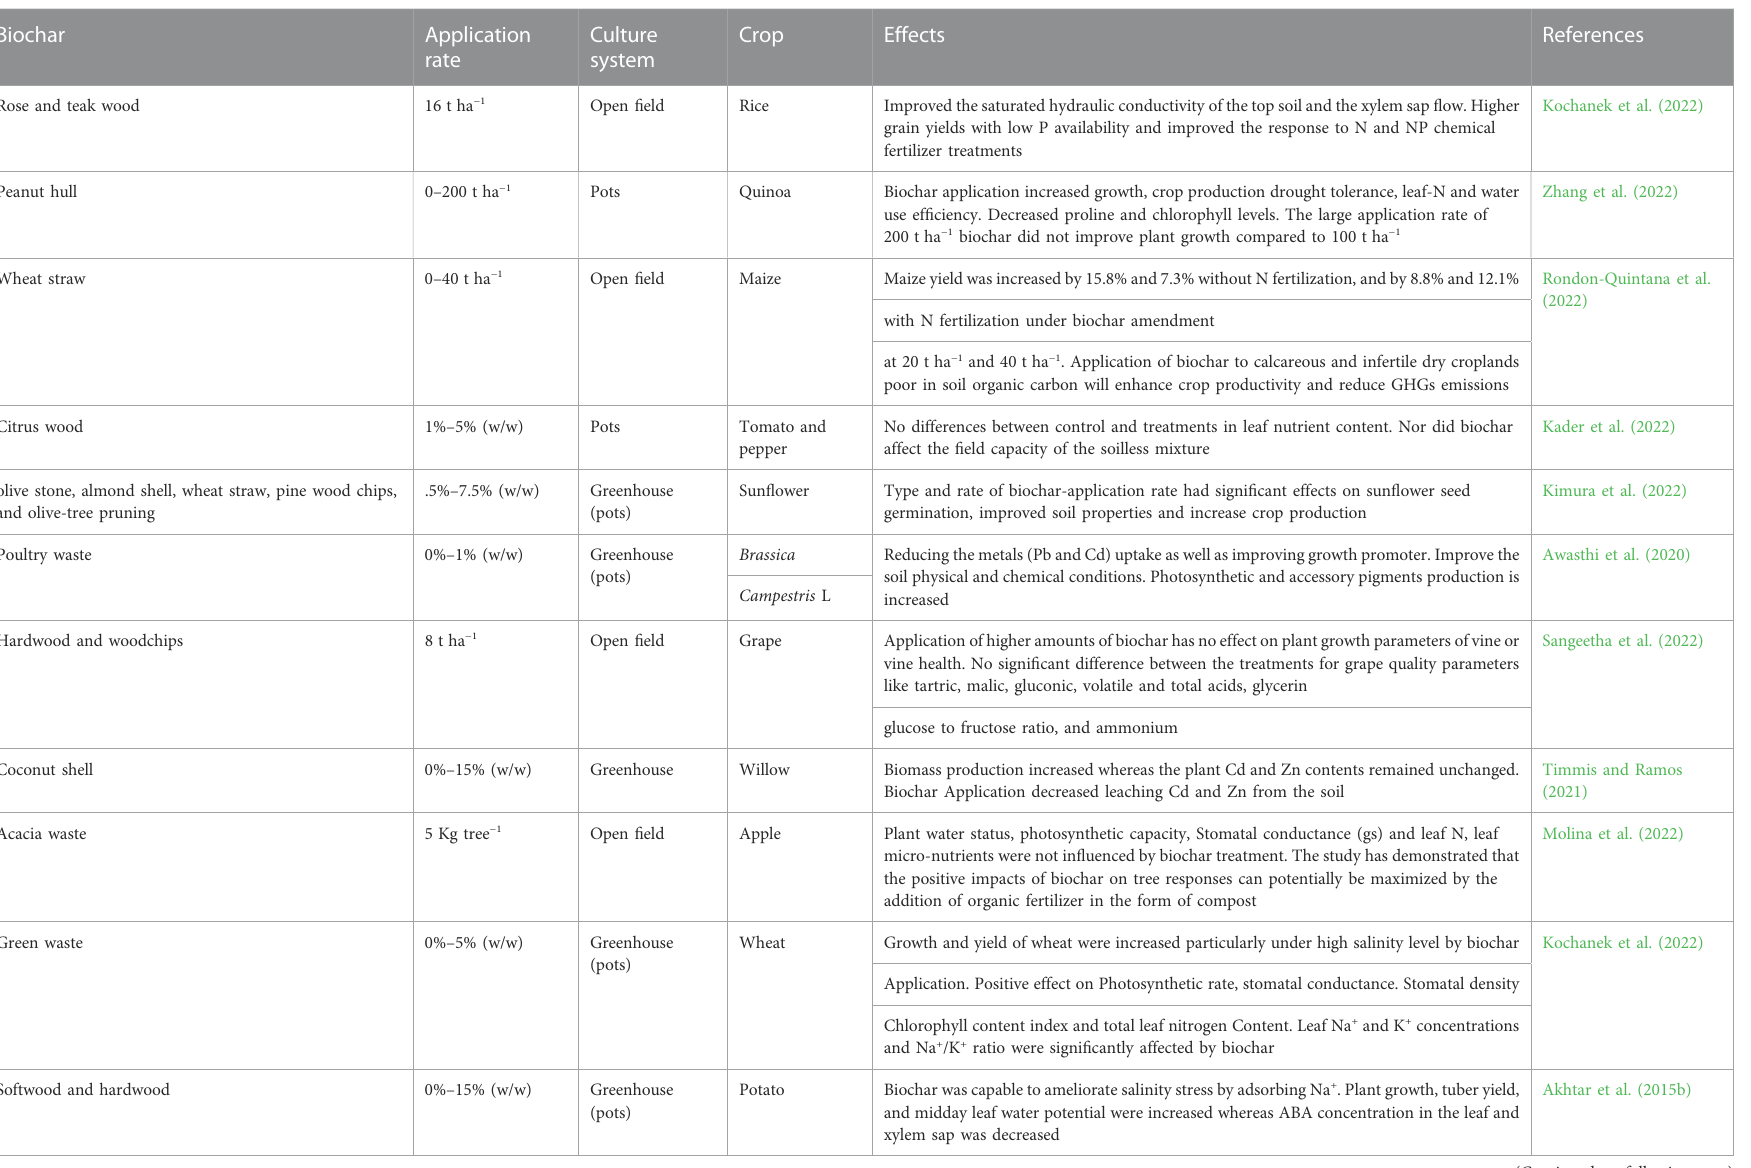
TABLE 4 Impacts of biochar addition on plant growth, development and crop